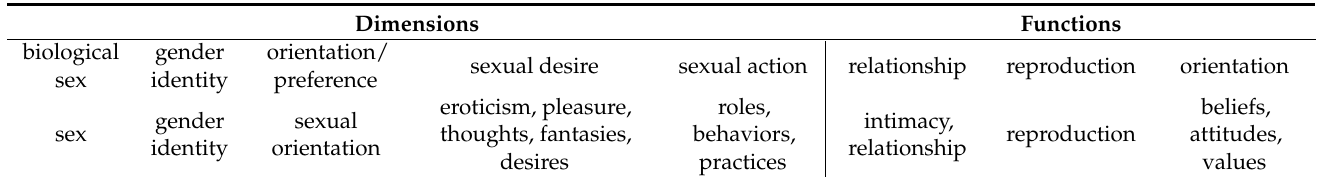
Table 1. Presentation of proposed dimensions and functions of sexuality with reference to the WHO’s working definition from 2002. In the upper row, you find the proposed dimensions and functions. In the lower row, the corresponding terms of the WHO’s working definition are